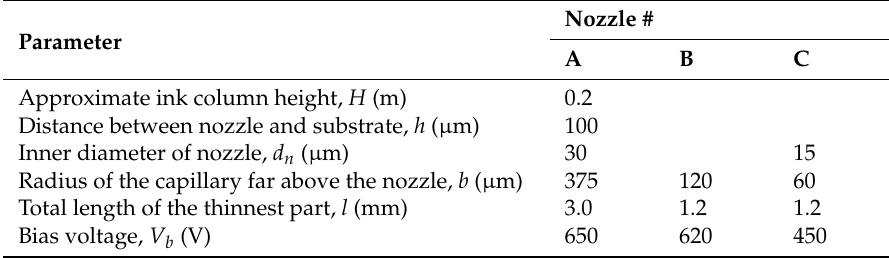
Table 1. Parameters of the experimental set-up.